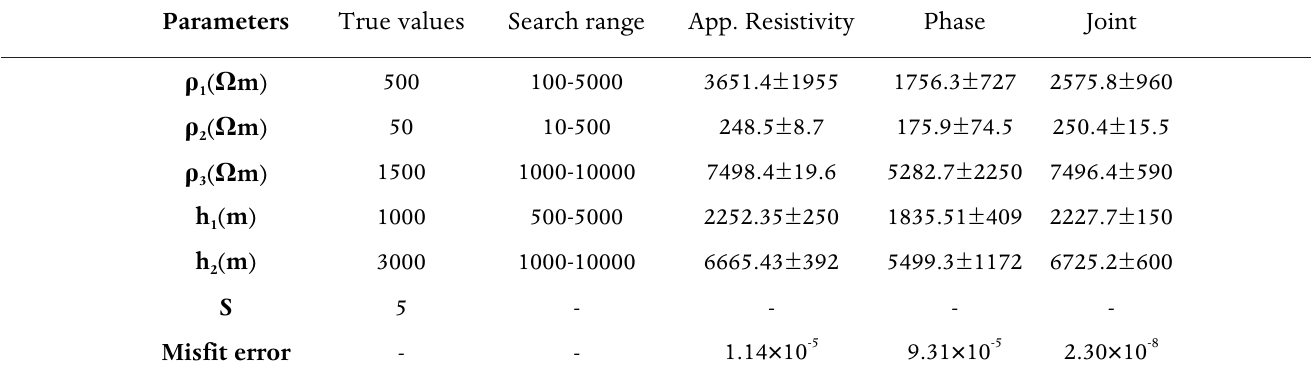
Table 1. Model 1: inversion results without optimization of static